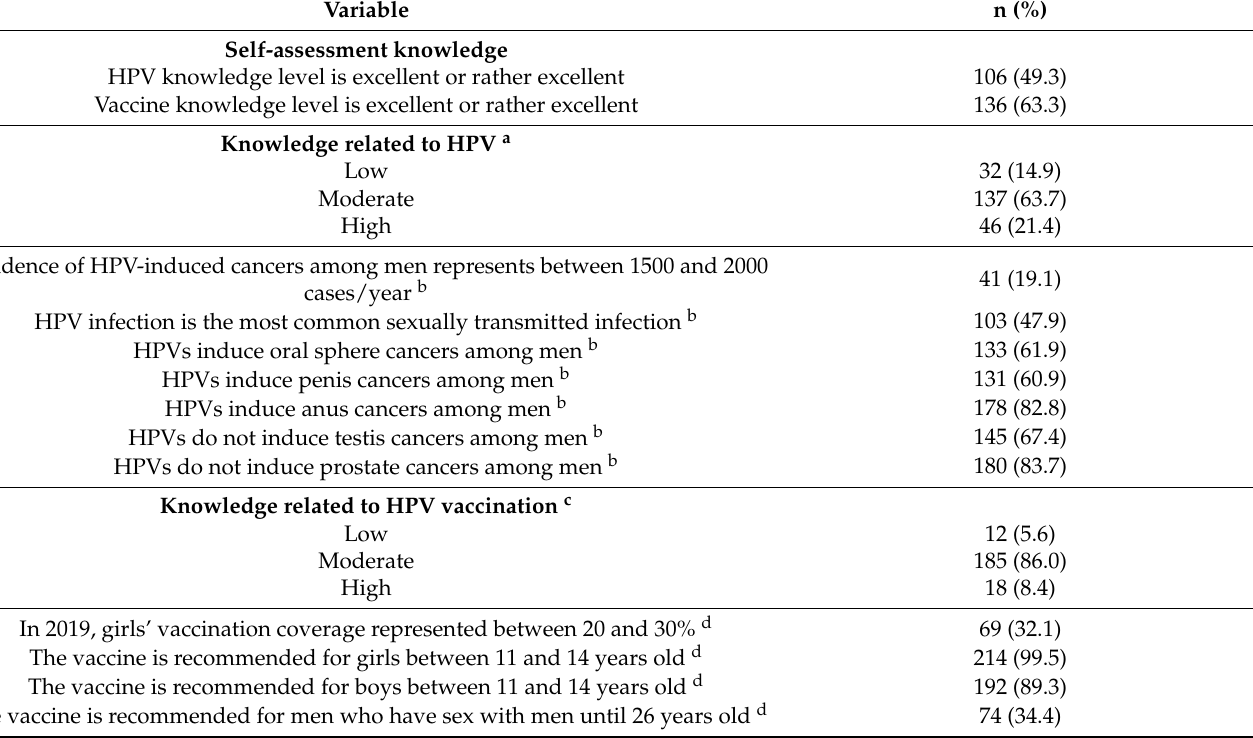
Table 2. Knowledge of pharmacists related to HPV and HPV vaccination among French